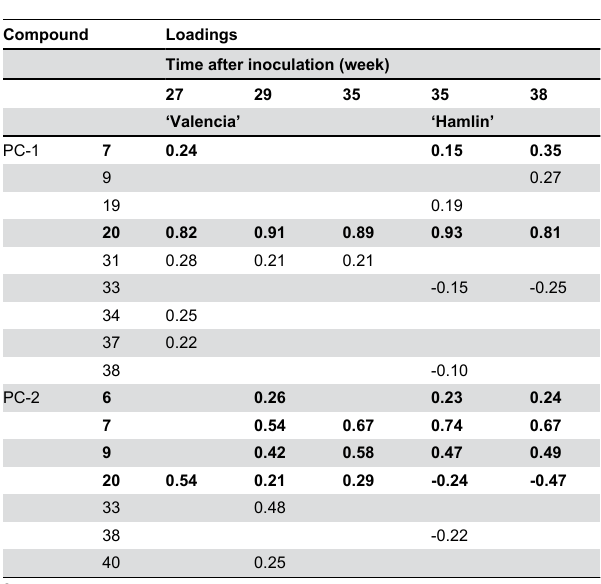
Table 4. Loadings from PCA for metabolites in leaves from ‘Valencia’ or ‘Hamlin’ at sampling dates when group clustering was observed a